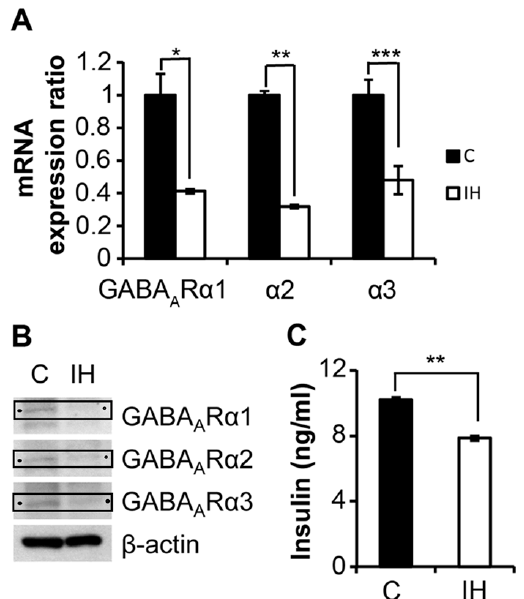
Figure 4. Comparisons between control and IH measurements on insulin secretion and GABA A receptor expression in rat pancreatic islets. ( A ) mRNA activity of GABA A receptor subtypes α 1, α 2 and α 3 in pancreatic islets is decreased after IH exposure ( n = 3) compared with the control samples ( n = 3). ( B ) Western blots showing the protein levels of corresponding GABA A receptors, as indicated by arrows. Full-length blots are found in the Supplementary Information, Figure S2. ( C ) Serum insulin levels determined by ELISA 3 weeks after postnatal IH exposure compared with control animals. IH (open bar) group ( n = 5); C (closed bar) Control group ( n = 5). * indicates p = 0.0015, ** indicates p < 0.0001, *** indicates p = 0.0021.